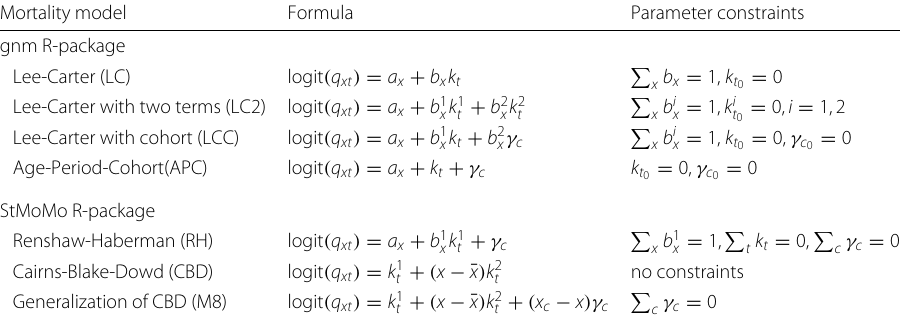
Table 1 List of mortality models equations and parameter constraints Mortality model Formula Parameter